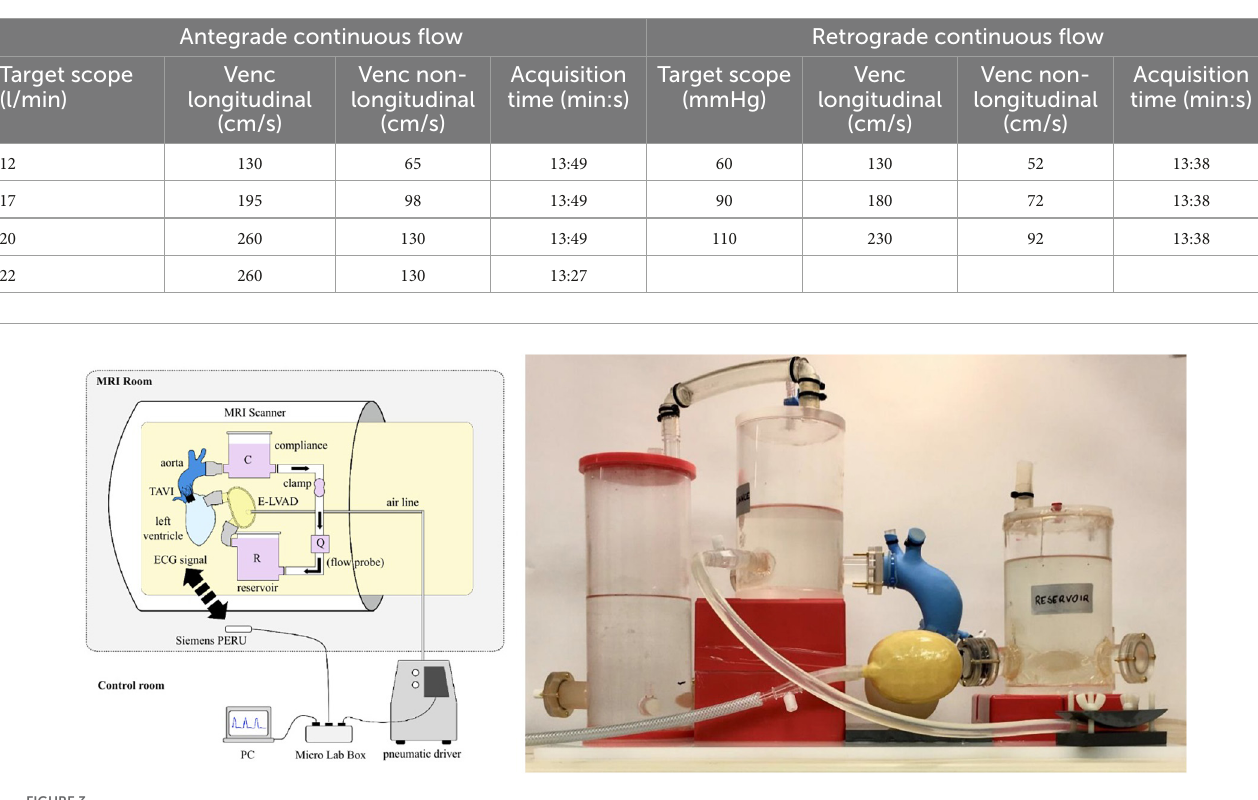
TABLE 1 MR encoding rates and acquisition times used in continuous flow acquisitions (longitudinal means the direction parallel to the direction of flow in the ascending aorta).